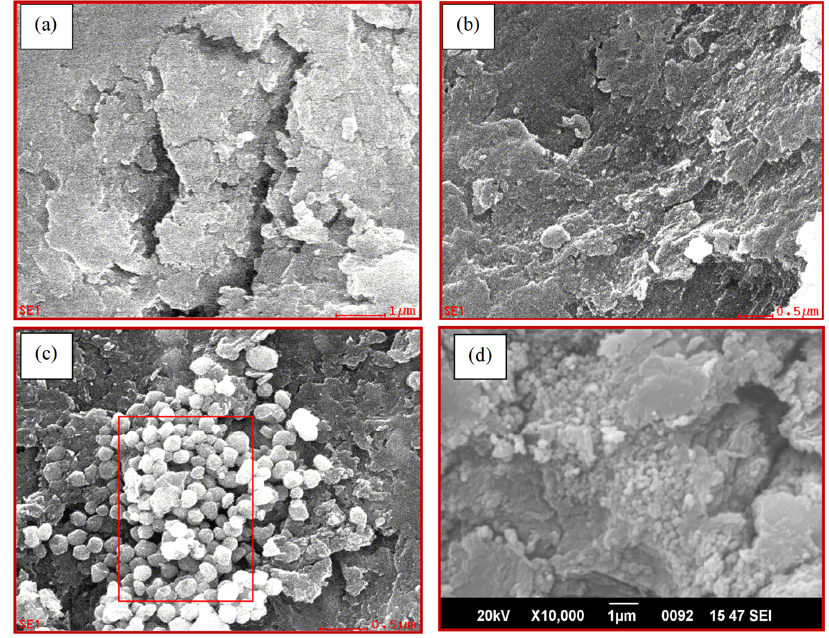
Figure 6. SEM images of ( a ) CABs, ( b ) AVCABs, and ( c ) AVMNCABs before adsorption and ( d ) AVMNCABs after adsorption.